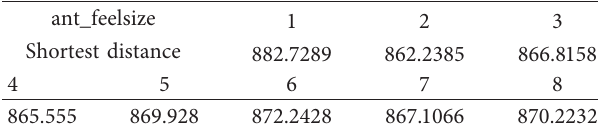
Table 7: Influence of different ant_feelsize on algorithm